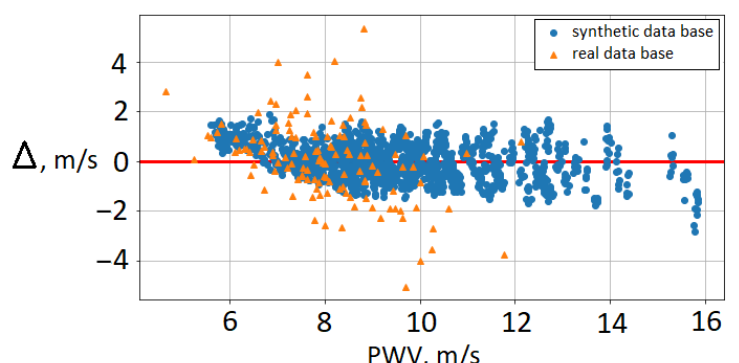
Figure 3. Bland–Altman plot for brachial–ankle AoPWV: cross-validation on the synthetic database (blue circles) and comparison with brachial–ankle AoPWV calculated for real patients (orange triangles). ∆ —difference between brachial–ankle AoPWV predicted by the neural network and subject’s brachial–ankle